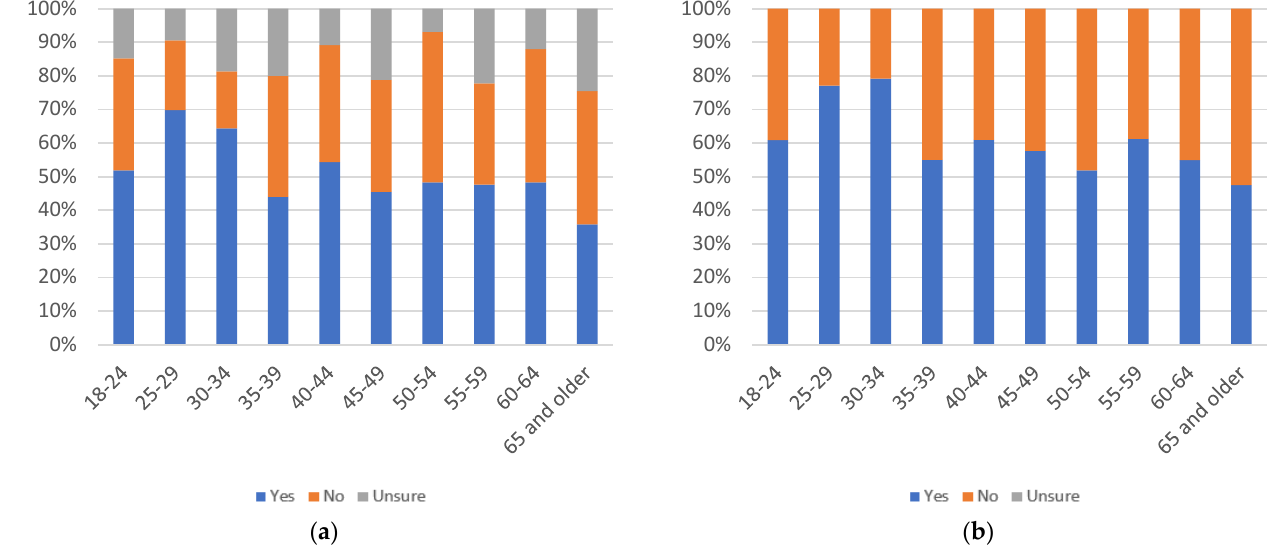
Figure 113. Label trustworthiness judging use, by age group: ( a ) with uncertain respondents (left) and ( b ) without uncertain respondents (right).